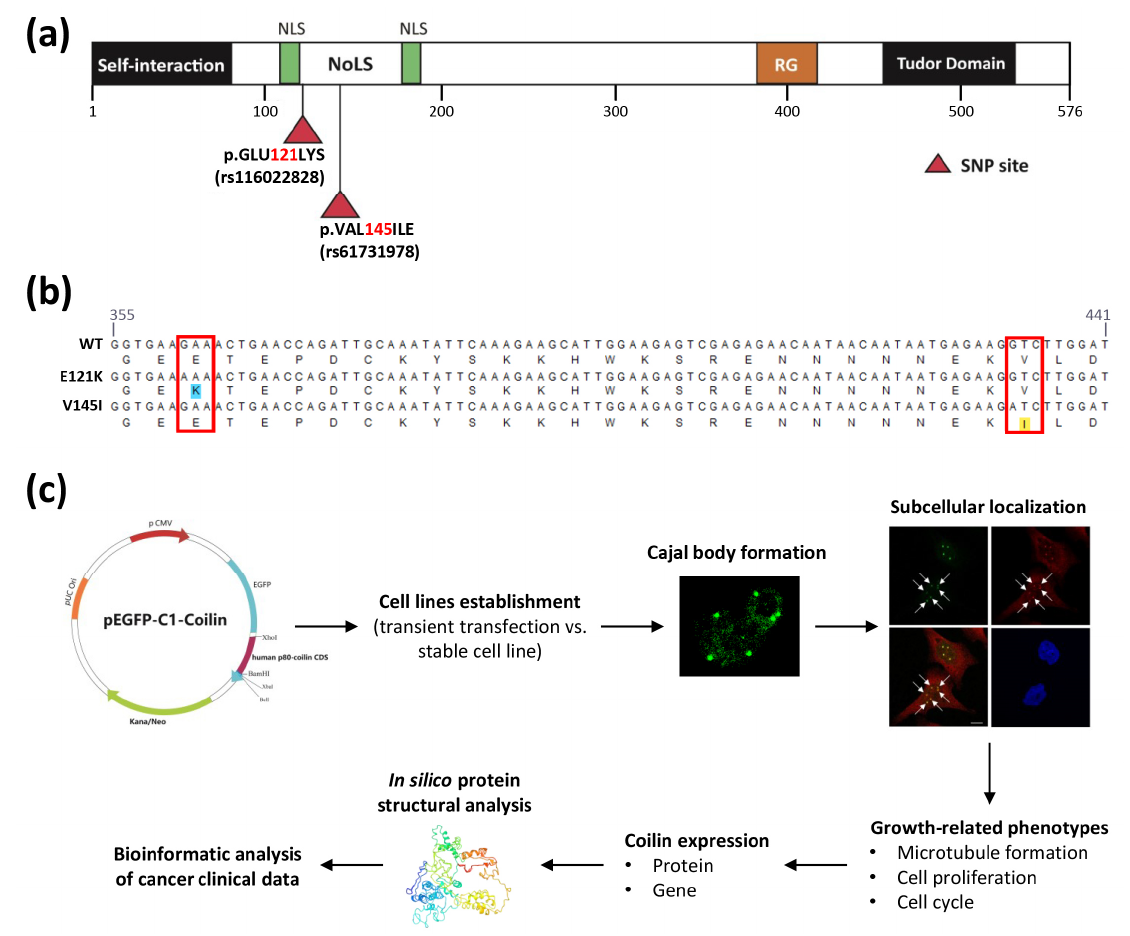
Figure 1. Establishment of cervical cancer (HeLa) cell lines expressing coilin single nucleotide polymorphism (SNP) variants. ( a ) Schematic structure of human coilin containing the self-interaction domain, nuclear localization signals (NLSs), nucleolar localization signal (NoLS), tri-RG motif, and tudor domain. The two coilin nonsynonymous SNPs (rs116022828 and rs61731978) are located between the NLSs where a cryptic NoLS is positioned. ( b ) DNA and amino acid sequence alignments of coilin SNP sites. For rs116022828, there is a Glu-to-Lys substitution at position 121 (E121K), while for rs61731978, there is a Val-to-Ile substitution at position 145 (V145I). ( c ) Experimental design and workflow in this study.